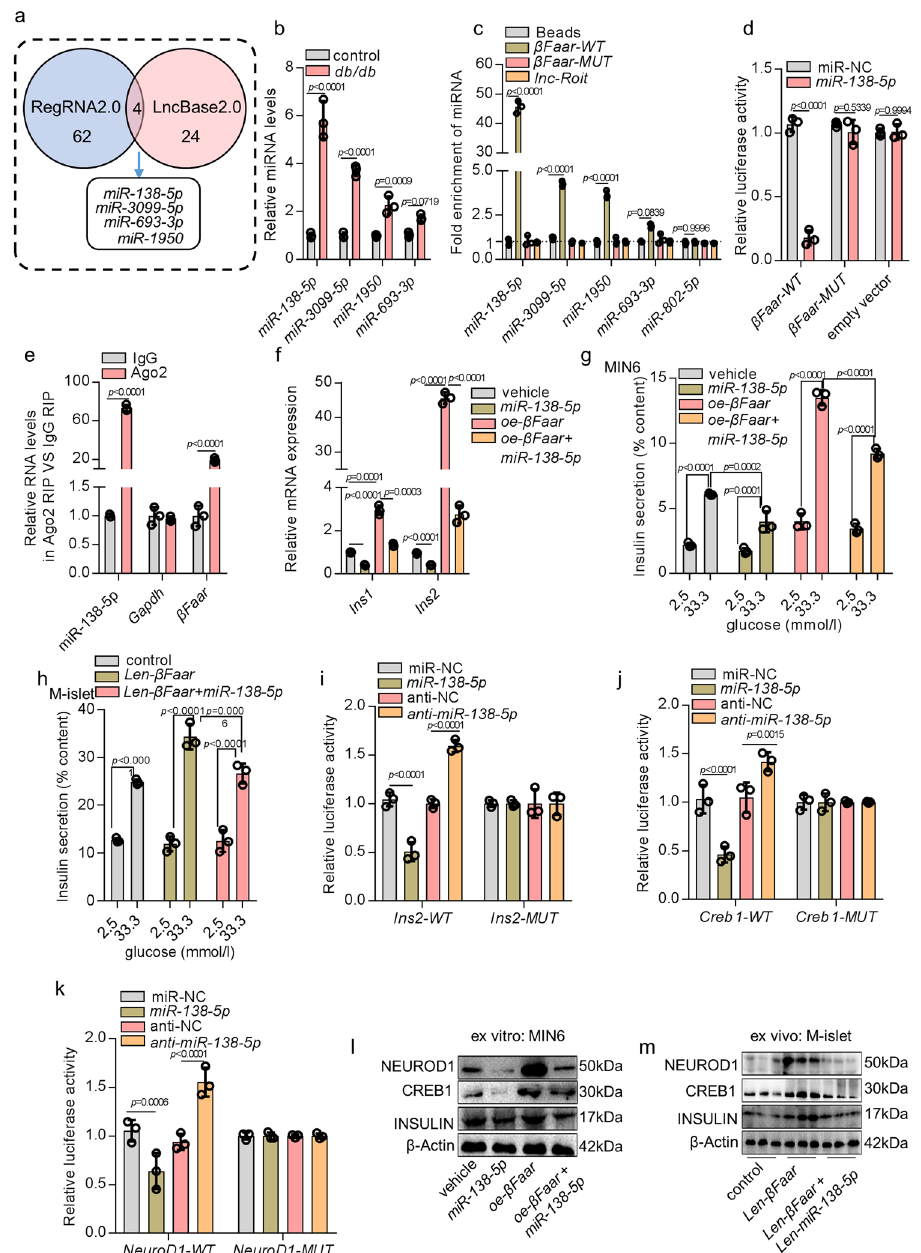
Fig. 6 β Faar regulates insulin transcription by sponging miR-138-5p . a RegRNA2.0 and LncBase2.0 were used to predict the target miRNA of β Faar , b qRT-PCR was performed to detect the expression levels of miR-138-5p , miR-3099-5p , miR-1950 , and miR-693-5p in the islets of db/db mice. c MIN6 cell lysates were incubated with biotin-labeled β Faar , after pull-down, microRNAs were extracted and assessed by qRT-PCR. Nontargeting microRNA ( miR-802-5p ) and lncRNA Roit are also inhibited by obesity, but does not have a predicated miRNA targeting site. d Relative luciferase activity in MIN6 cells co-transfected with a luciferase reporter containing either β Faar-WT or β Faar - MUT ( miR-138-5p -binding sequence mutated) and miR-138-5p mimics. Data are presented as the relative ratio of renilla luciferase activity and fi re fl y luciferase activity. e Anti-Ago2 RIP was performed in MIN6 cells transiently overexpressing miR-138-5p , followed by qRT-PCR to detect β Faar associated with Ago2 (non-speci fi c IgG as negative control). f , g miR-138- 5p or β Faar was overexpressed in the MIN6 cells, qRT-PCR was performed to detect the Ins1 and Ins2 levels ( f ) and ELISA was carried out to test the insulin secretion ( g ). The insulin secretion in the islets of len- β Faar treated mice or both len-miR-138-5p and len- β Faar treated mice ( h , n = 5). Relative luciferase activity in MIN6 cells co-transfected with a luciferase reporter containing either Ins2 - WT or In2 - MUT ( i ), Creb1 - WT or Creb1 - MUT ( j ), NeuroD1 - WT or NeuroD1 - MUT ( k ) and miR-138-5p mimics. Data are presented as the relative ratio of renilla luciferase activity and fi re fl y luciferase activity. The protein levels of INSULIN, CREB1, and NEUROD1 in the MIN6 cells transfected with miR-138-5p mimics or β Faar overexpression plasmid ( l ) and in the islet cells of len- β Faar treated mice or both len-miR-138-5p and lent- β Faar treated mice ( m , n = 5). All experiments above were performed in triplicates, and each group contained three batches of individual samples. The p -values by two-way ANOVA ( b – k ) are indicated. Data represent the mean ± SD. Source data are provided as a Source data fi le.